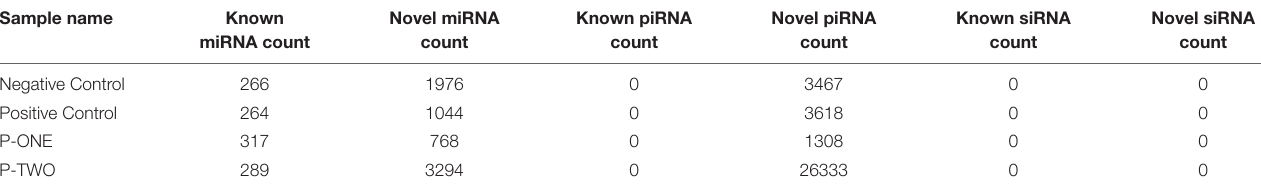
TABLE 3 | Summary of detected small non-coding RNAs for each